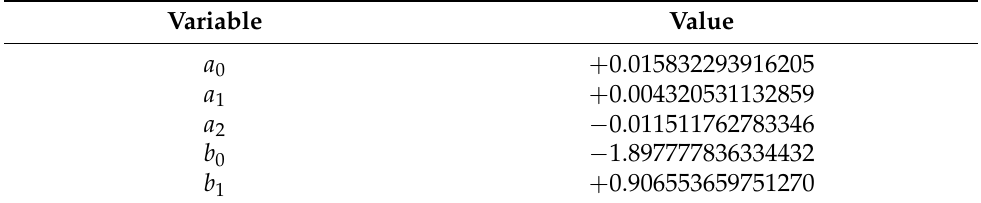
Table A2. Difference in equation constants for the y Cartesian axis.